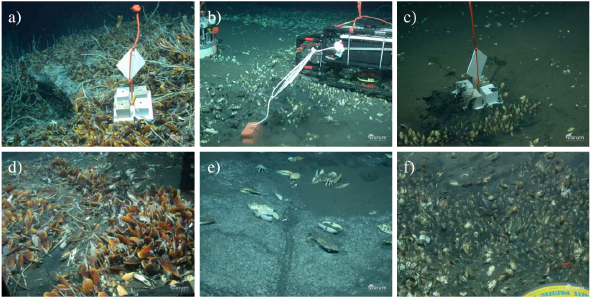
Fig. 2. Typical habitats at the REGAB pockmark: central area with extensive carbonate crust and outcropping hydrates populated by mussels and tubeworms (a) ; clam patches overlying blackened re- duced sediment (b) , (c) , (f) ; mussel patch on soft sediment (d) ; white bacterial mat at the REGAB N (e) ; Benthic chamber incu- bation is visible in (b)